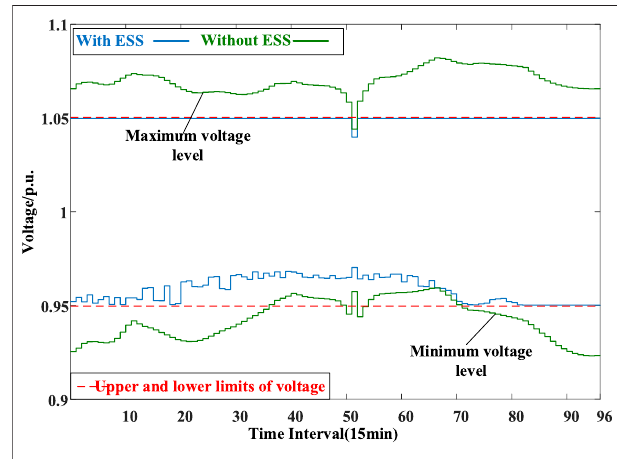
FIGURE 7 | The maximum and minimum voltage levels (p.u.) across the network without or with the ESS deployment in a day. FIGURE 6 | Daily voltage pro